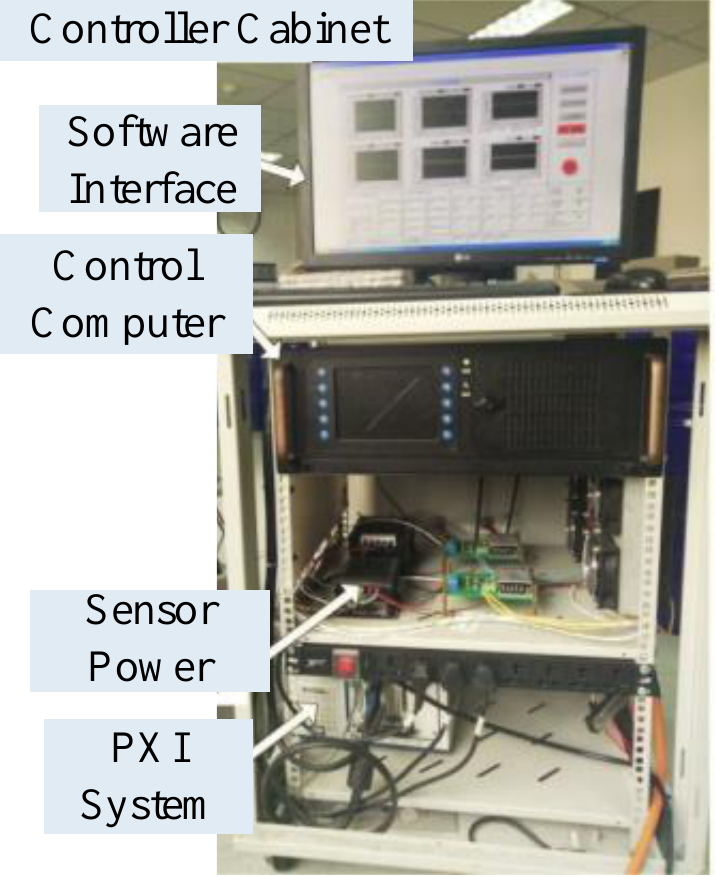
Figure 20. Signal acquisition and control system.